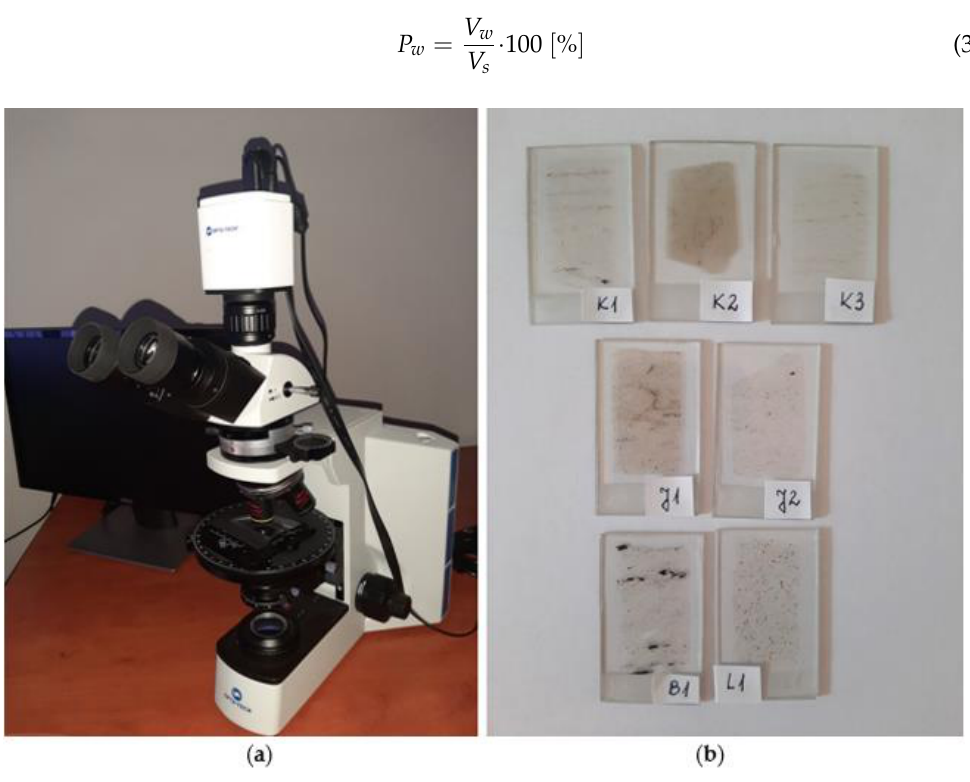
Figure 3. Petrographic and mineralogical analyses: ( a ) OPTA-TECH LAB-40 HAL polarizing diagnostic microscope; ( b ) thin sections.